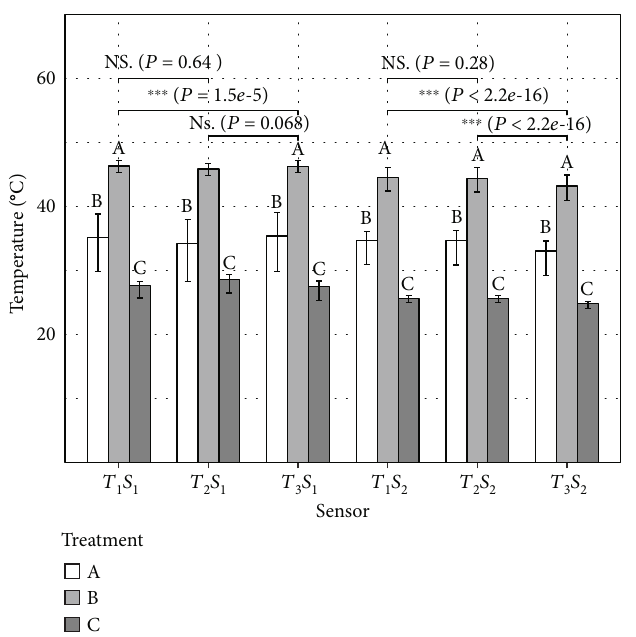
Figure 10: Post hoc Tukey ’ s HSD test and Wilcoxon pair comparison results by